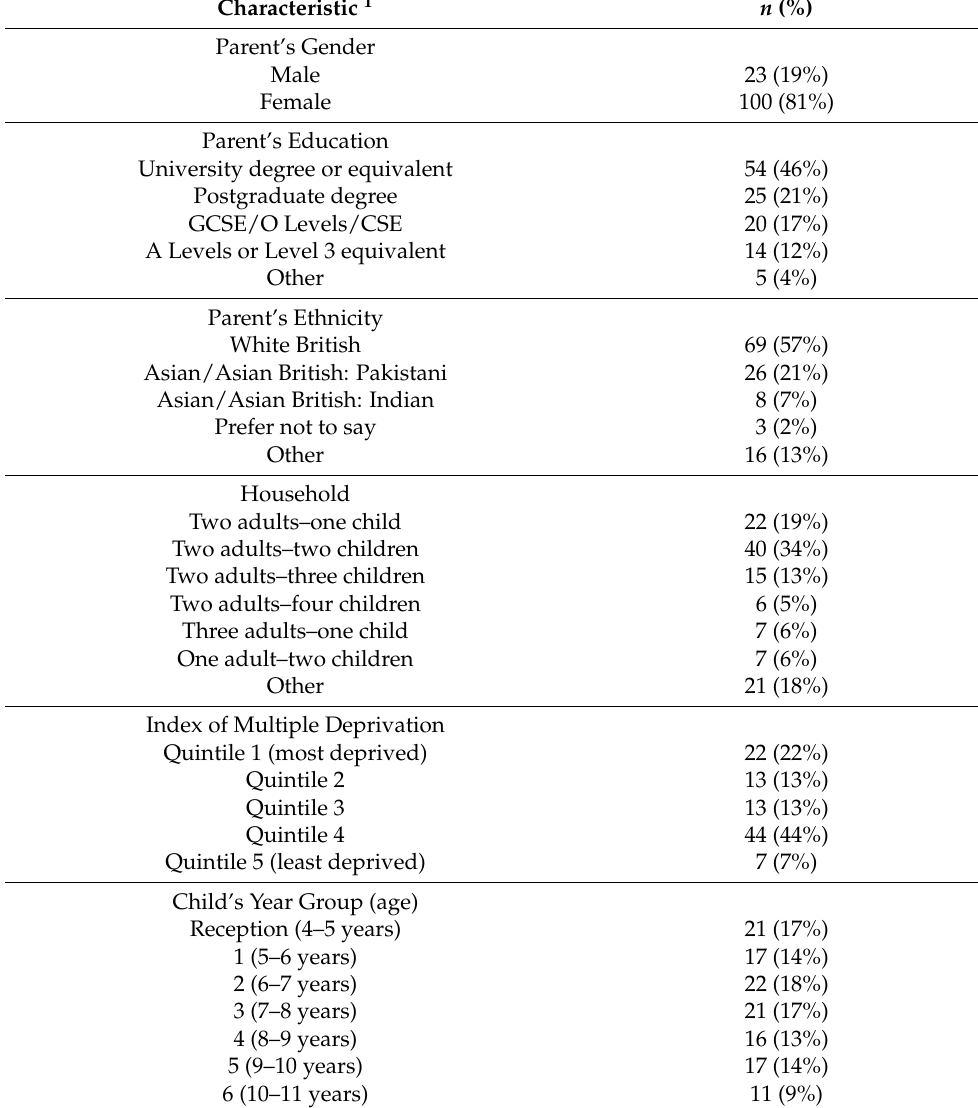
Table 2. Demographic characteristics of respondents ( n = 125) and their